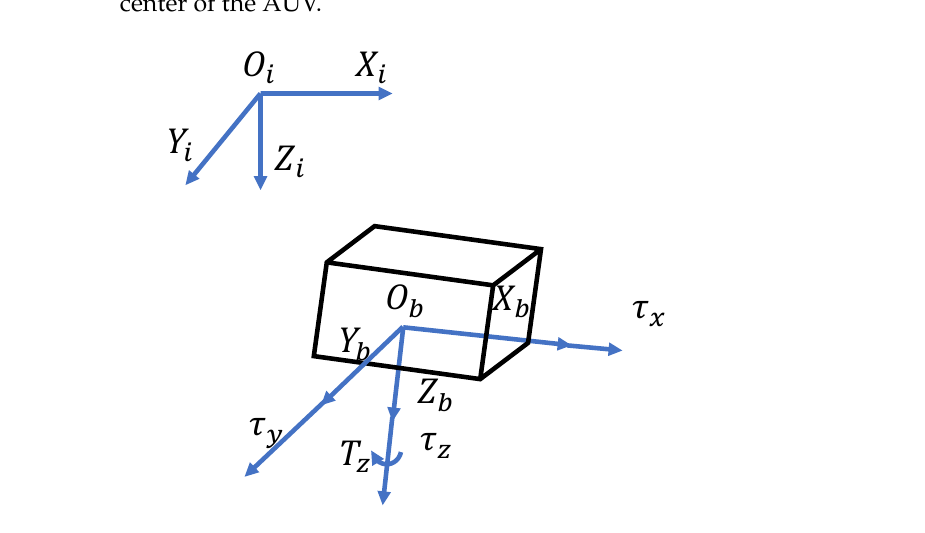
Figure 1. Coordinate frames and control inputs of the